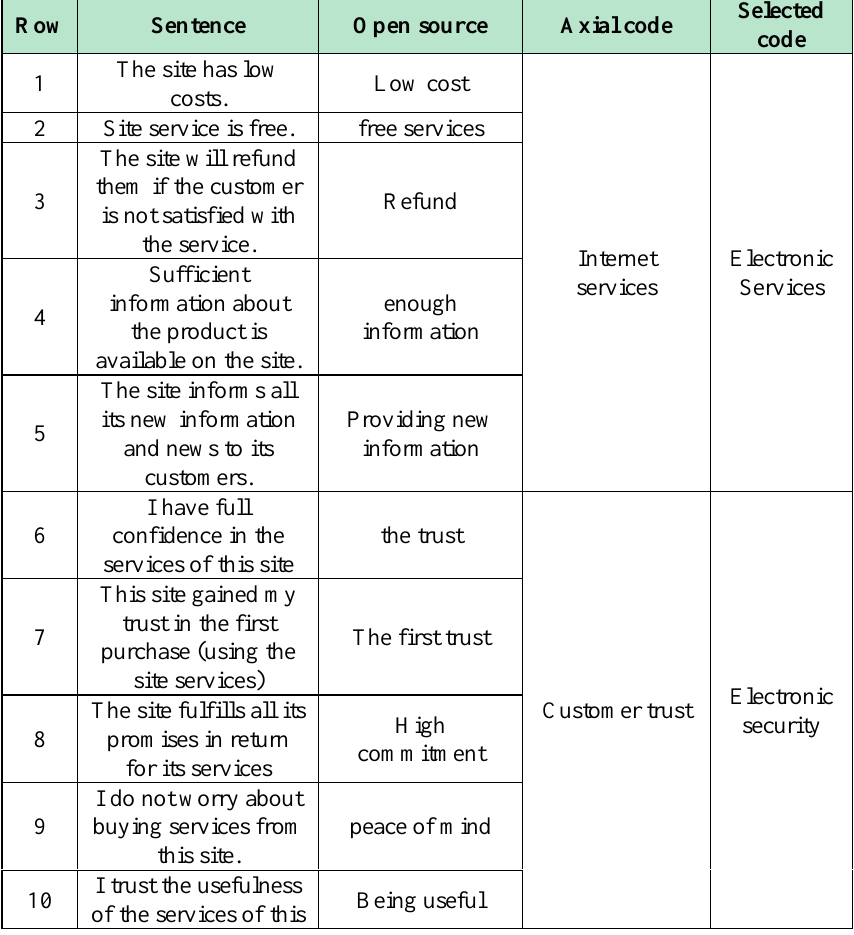
Table 2: Identification of viral marketing components inferred from interview coding (Authors